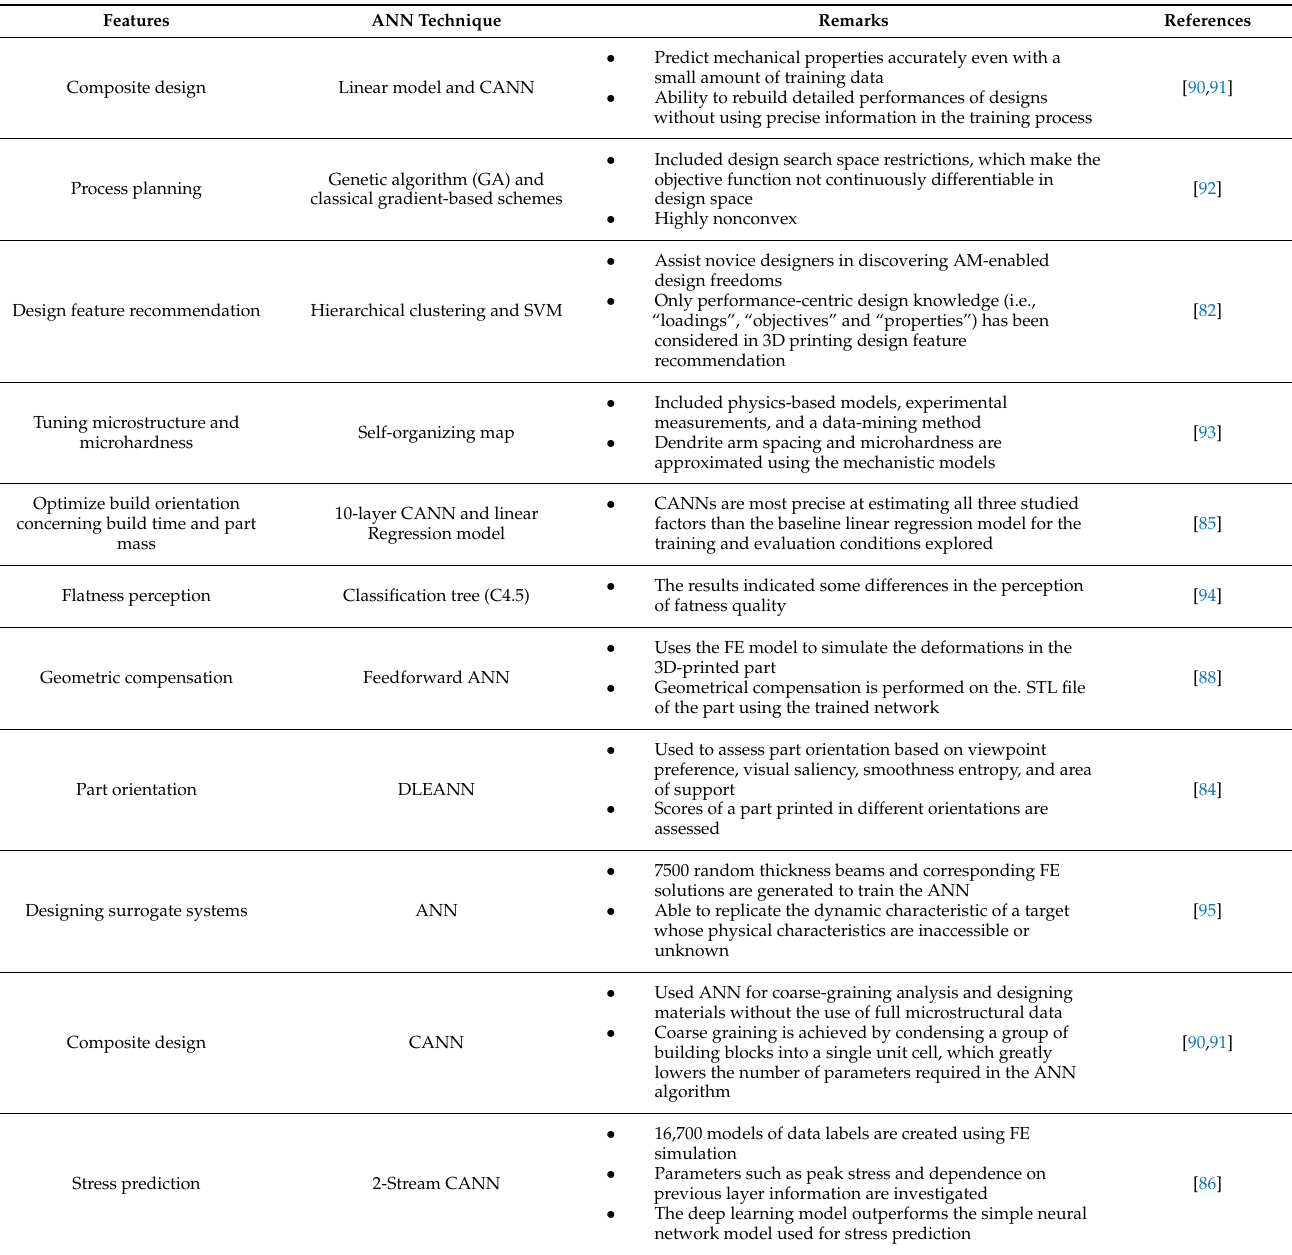
Table 5 provides a summary of research works on ANNs in design for 3D printing. Table 5. ANN in various 3D printing